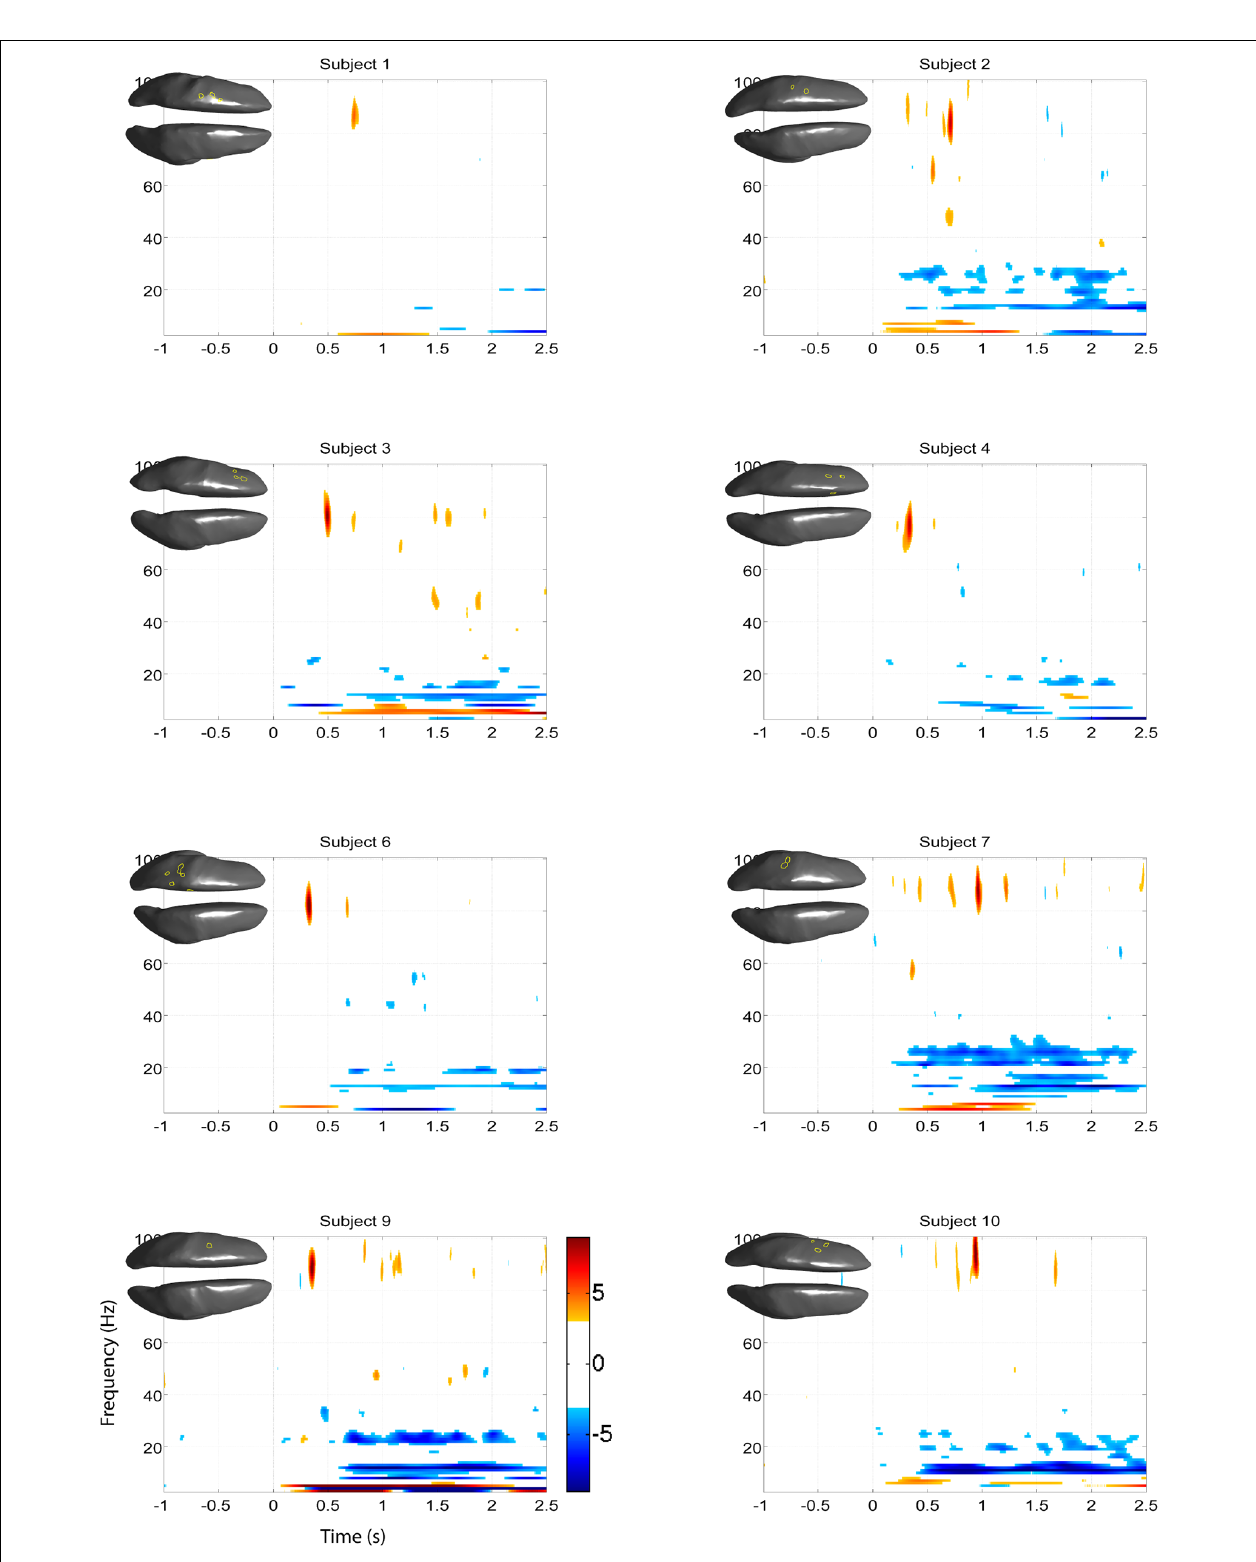
FIGURE 11 | Z -score time-frequency maps during right hand motor imagery of the eight remaining subjects for the cortical regions indicated on the cortical surface displayed in the upper left corner. The maps show that subjects have significant HG increases post-cue in a narrow band.